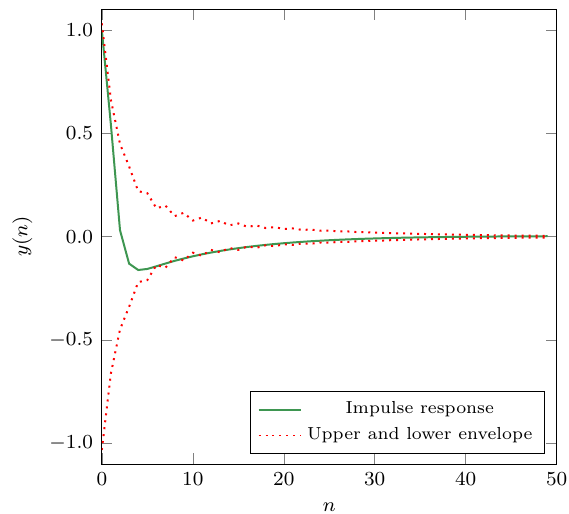
Figure 6. The impulse response of the proposed filter and its